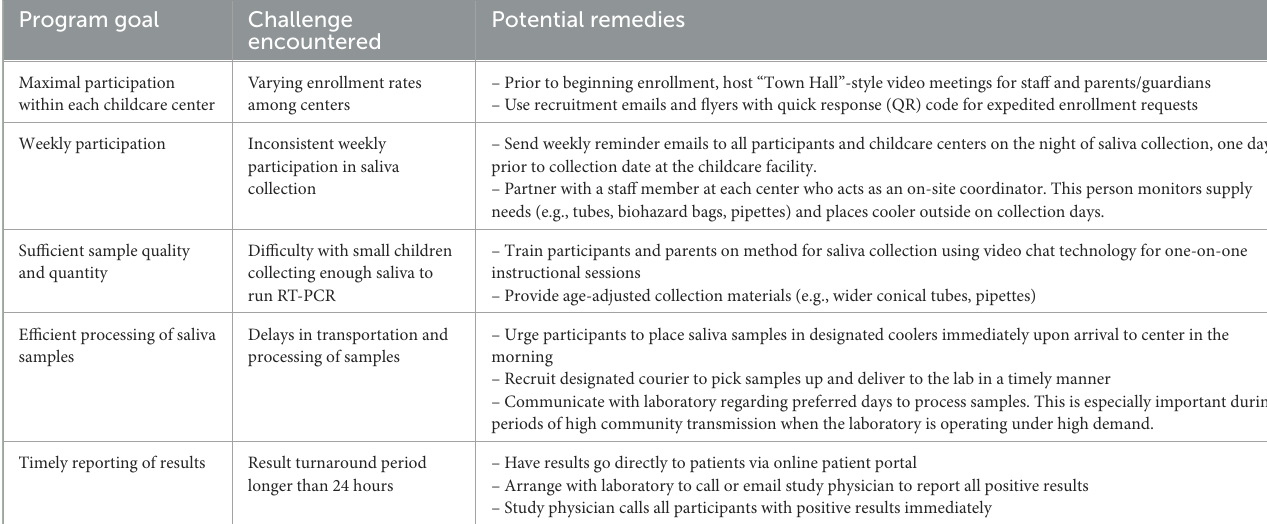
TABLE 2 Challenges and potential remedies of weekly saliva testing in childcare centers. We identified the goals of the study and the testing program, the challenge encountered, and suggested potential remedies to maximize the utility of this routine testing program. Program